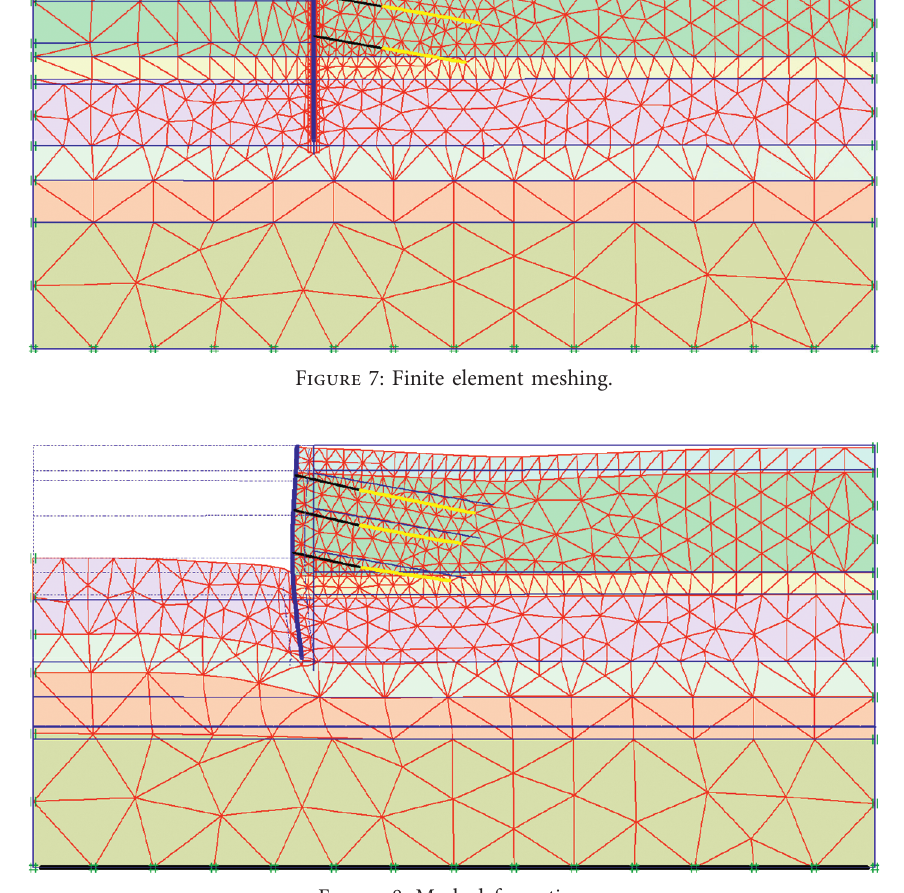
Figure 8: Mesh deformation.